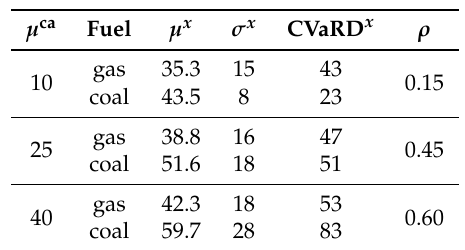
Table 3. Expected EECs and risk measures values ($ 2015/MWh) in the σ ca = 30% scenario for µ ca = 10, 25,